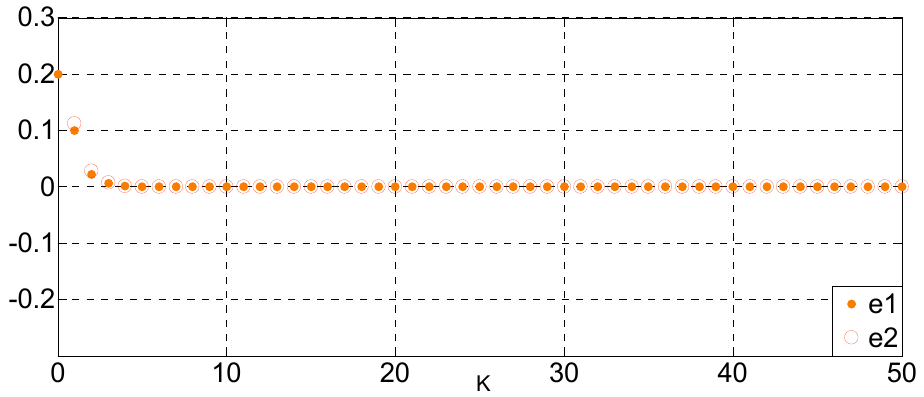
Figure 8. The state responses of the controlled master and slave CRNGs.